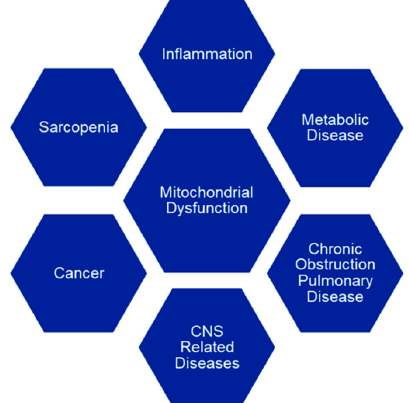
Figure 1. Mitochondrial dysfunction is implicated in many age-related diseases such as metabolic diseases (T2DM, obesity, cardiovascular and cerebrovascular disease, Non-Alcoholic Fatty Liver Disease (NAFDL)) [2–7], CNS-related diseases (Parkinson’s, Alzheimer’s and Huntington’s disease, hearing loss, cataracts) [8–11], inflammation (osteoarthritis) [12], cancer [13,14], sarcopenia [15] and chronic obstructive pulmonary disease (COPD) [16].